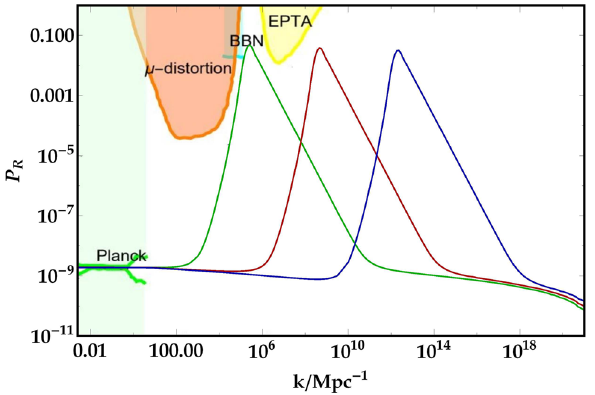
Fig. 2 The scalar power spectrum P R in terms of wavenumber k for thequarticinflationmodel.Theblue,redandgreenlinesarecorrespond- ing to the cases A H , B H and C H , respectively. The CMB observations exclude the light-green shaded area [29]. The orange zone shows the μ -distortion of CMB [85]. The cyan area represents the effect on the ratio between neutron and proton during the big bang nucleosynthesis (BBN) [86]. The yellow region demonstrates the constraint from the PTA observations [87]